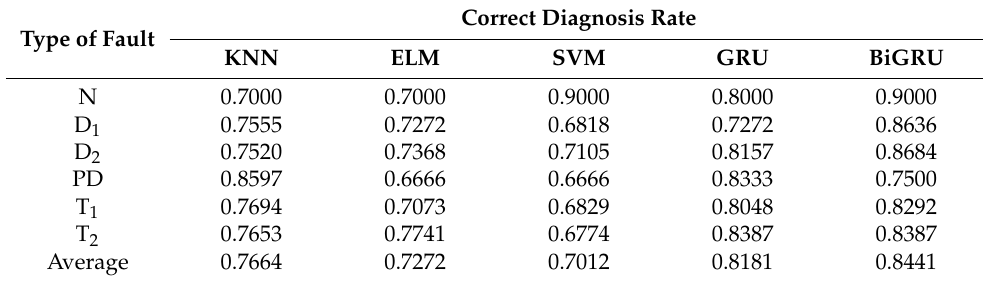
Table 9. Diagnostic Accuracy of Different